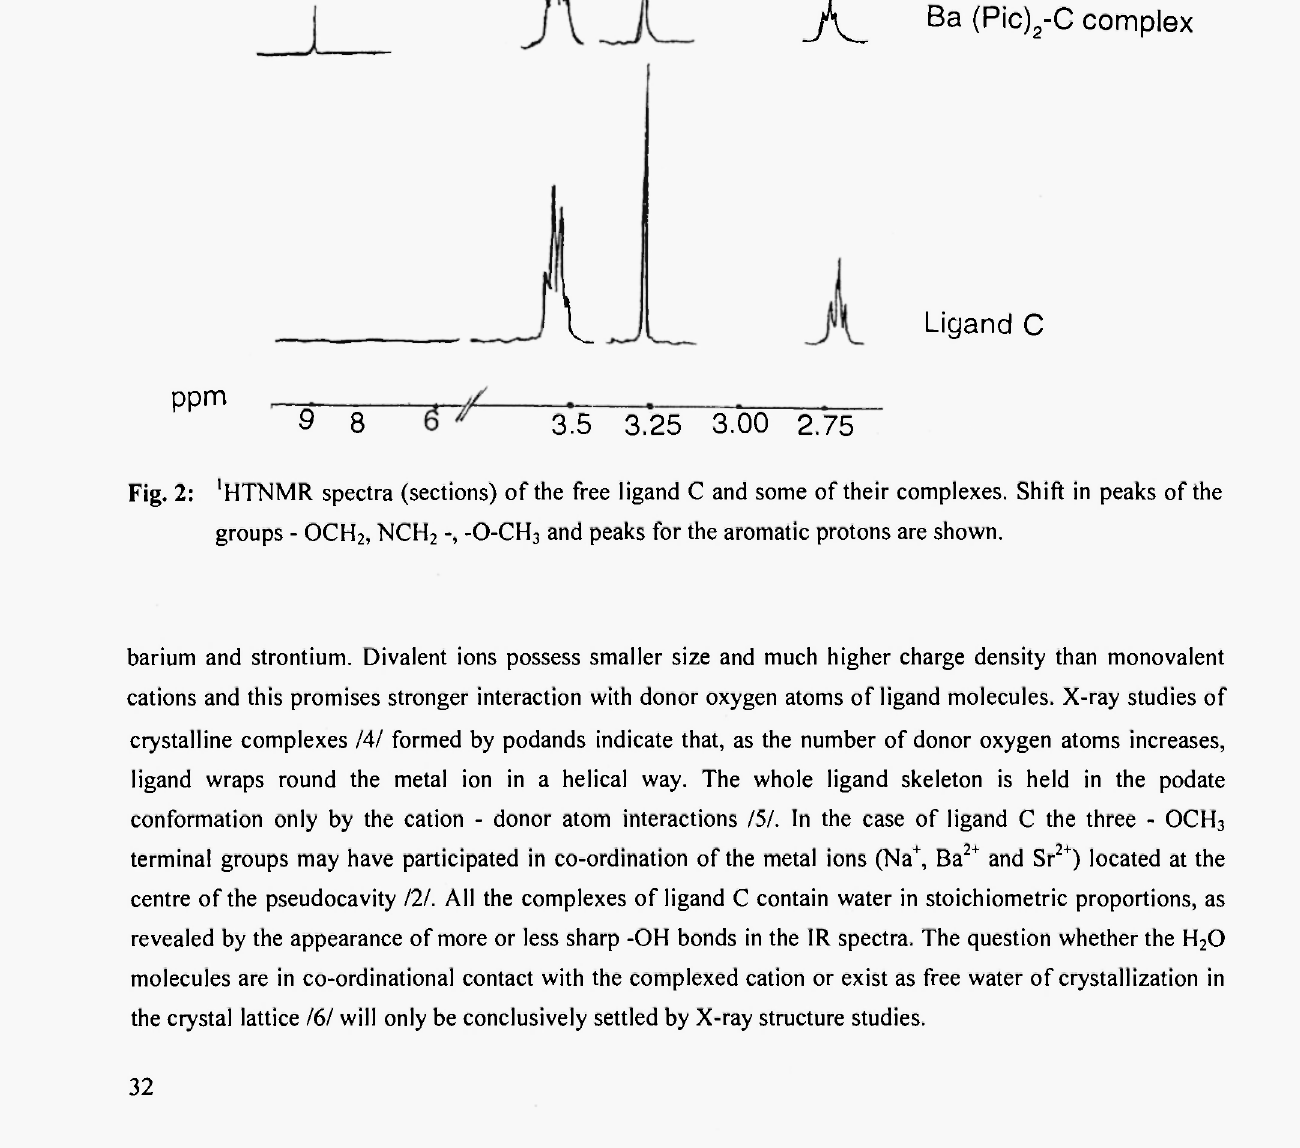
Fig. 2: 'HTNMR spectra (sections) of the free ligand C and some of their complexes. Shift in peaks of the groups - OCH 2 , NCH 2 -, -0-CH 3 and peaks for the aromatic protons are shown.